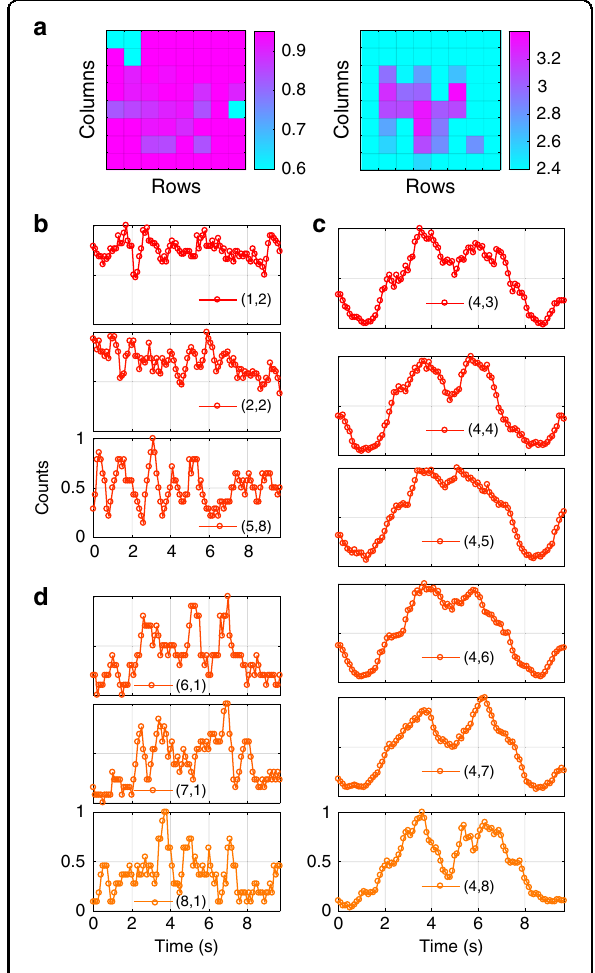
Fig. 7 Visibility and patterns observed at different pixels of the SPDA imager. a Visibility across all the pixels (left) and the reconstructed image drawn from correlation (right). b Observed (normalized) pattern at the three defective pixels having high dark counts. The correlation with the reference pattern is lower than threshold. c Observed (normalized) pattern at the bottom six pixels of column four. The correlation with the reference pattern is higher than the threshold. d Observed pattern (normalized) at bottom three pixels of column one. The correlation with the reference pattern is between the two previous extremes but still lower than the chosen threshold. By plotting the pixels with correlation higher than the threshold, the image was reconstructed with enhanced contrast as shown in fi g a